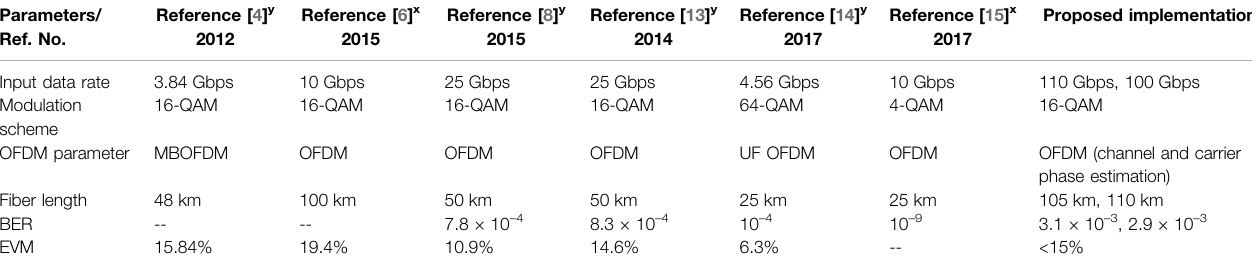
TABLE 1 | Comparison of the pervious implementation with the proposed 60 GHz mm-wave OFDM RoF. Parameters/ Ref.